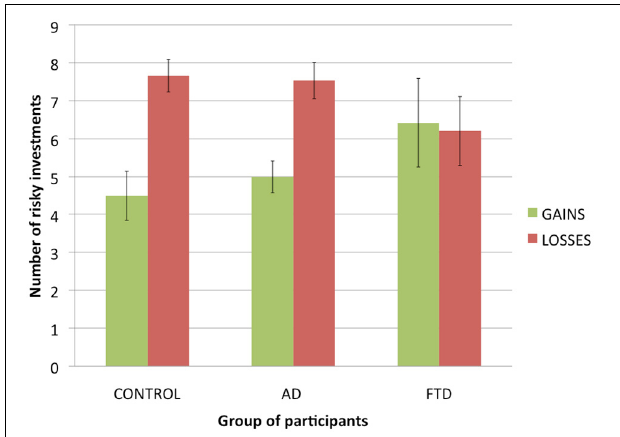
FIGURE 4 | Satisfaction ratings in function of potential gains ( + $2000 or − $2000) for each group of participants (error bars indicate standard